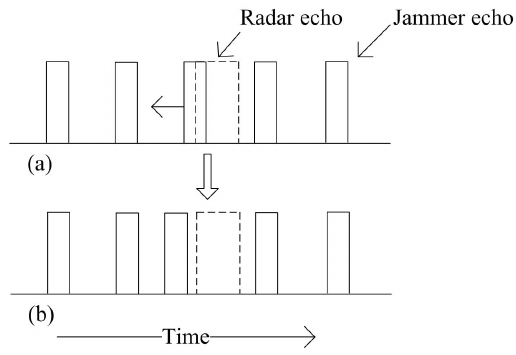
Figure 2. Relationship between radar echo and jammer echo.